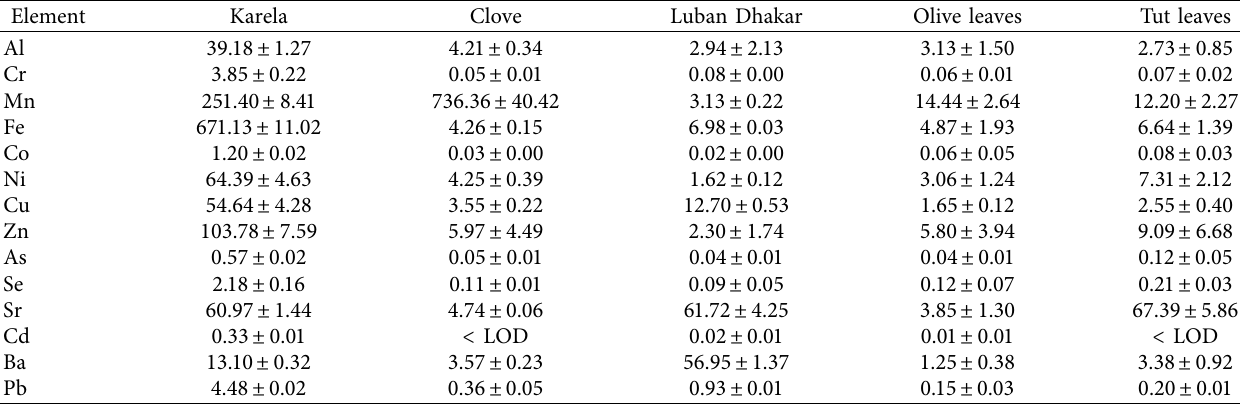
Table 3: Average concentrations ( µ g/g) of fourteen measured elements in five types of medicinal plants, mean ± SD ( n � 4) with a 95% confidence level. The infusion was one gram of each plant boiled in deionized water for ten minutes. Element